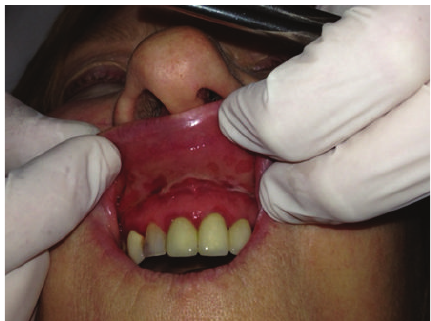
Figure 3: Gentian violet induced oral lesions.